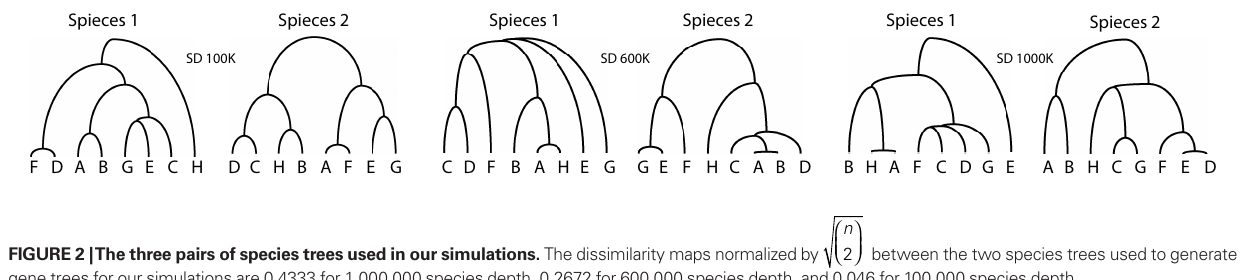
n    between the two species trees used to generate  2